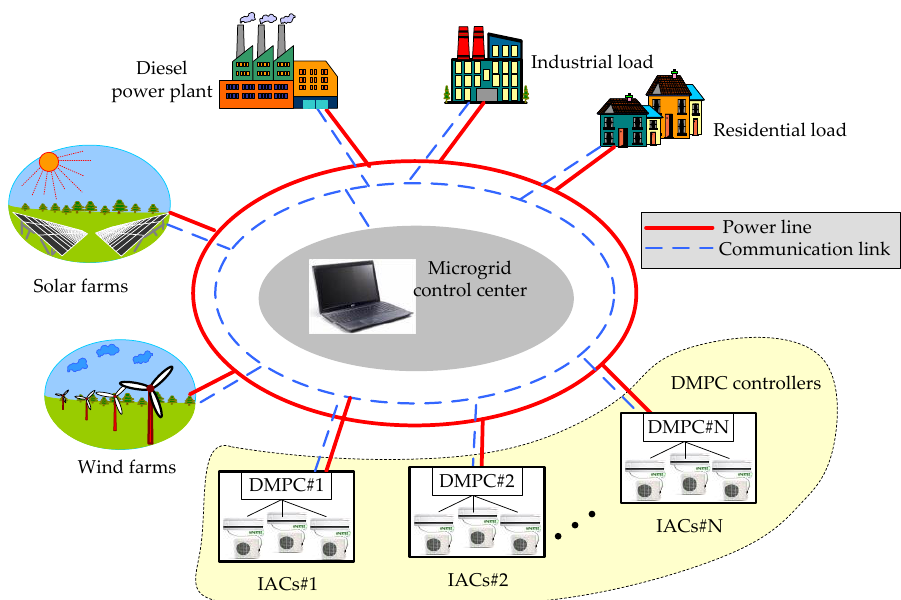
Figure 1. Microgrid with DMPC for IACs control.